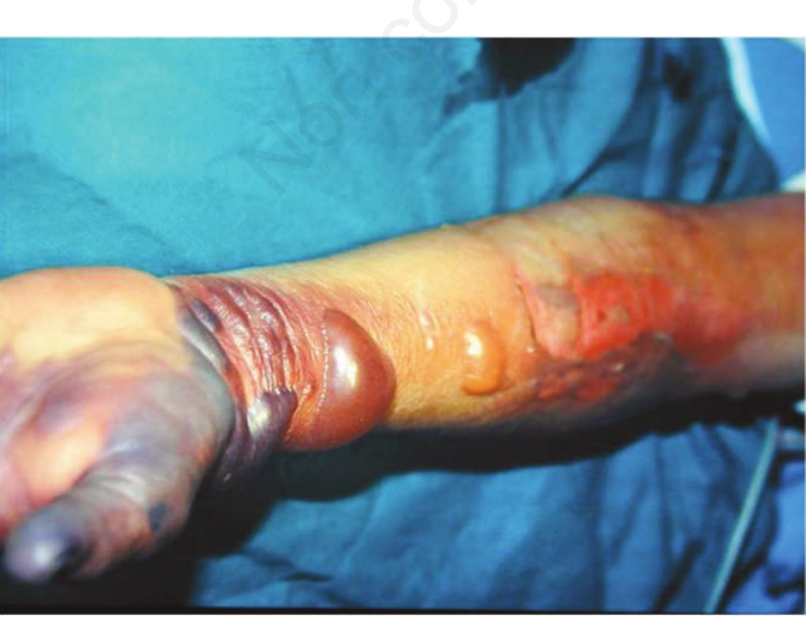
Figure 1. Left arm at hospital admission 36 h following